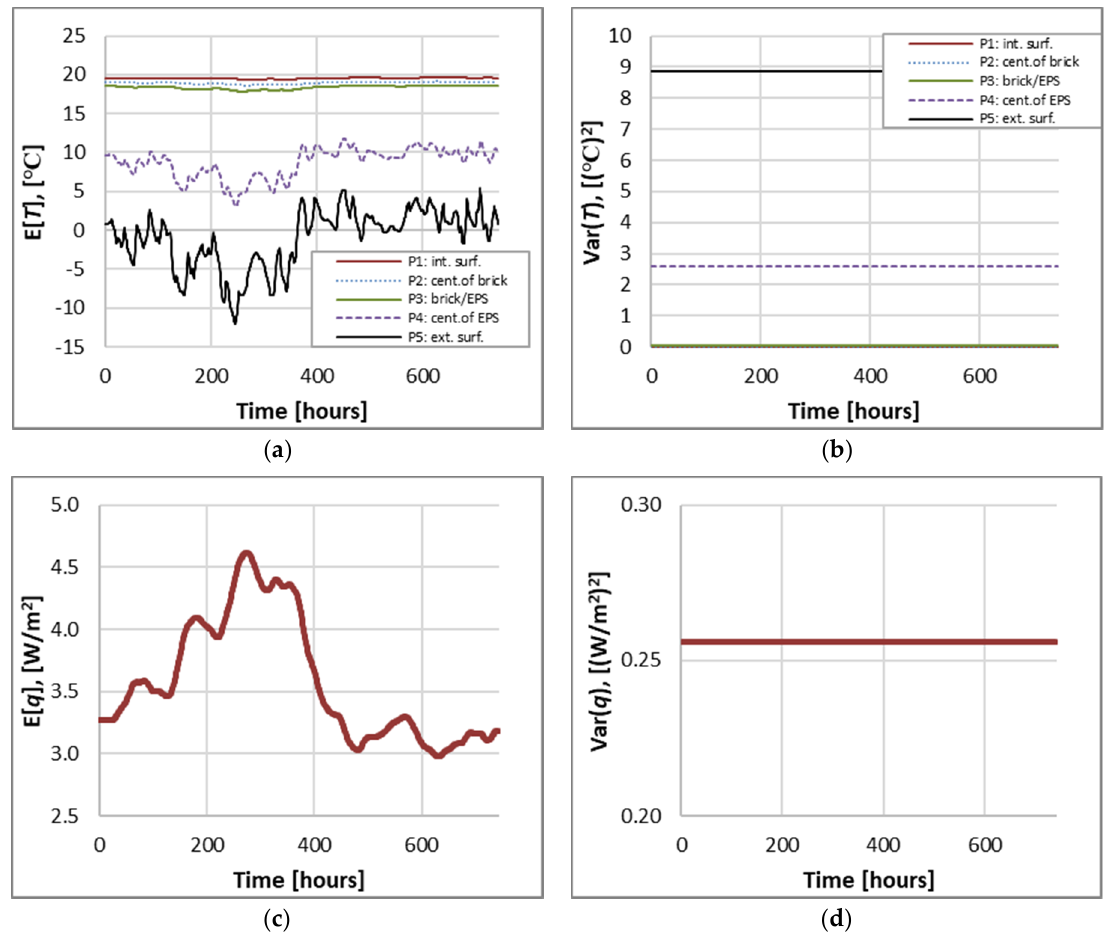
Figure 11. ( a ) E xpected value and ( b ) variance of temperature in 5 points in the wall and ( c ) expected value and ( d ) variance of heat flux on the internal side of the wall in January obtained using the perturbation method for Case 3.